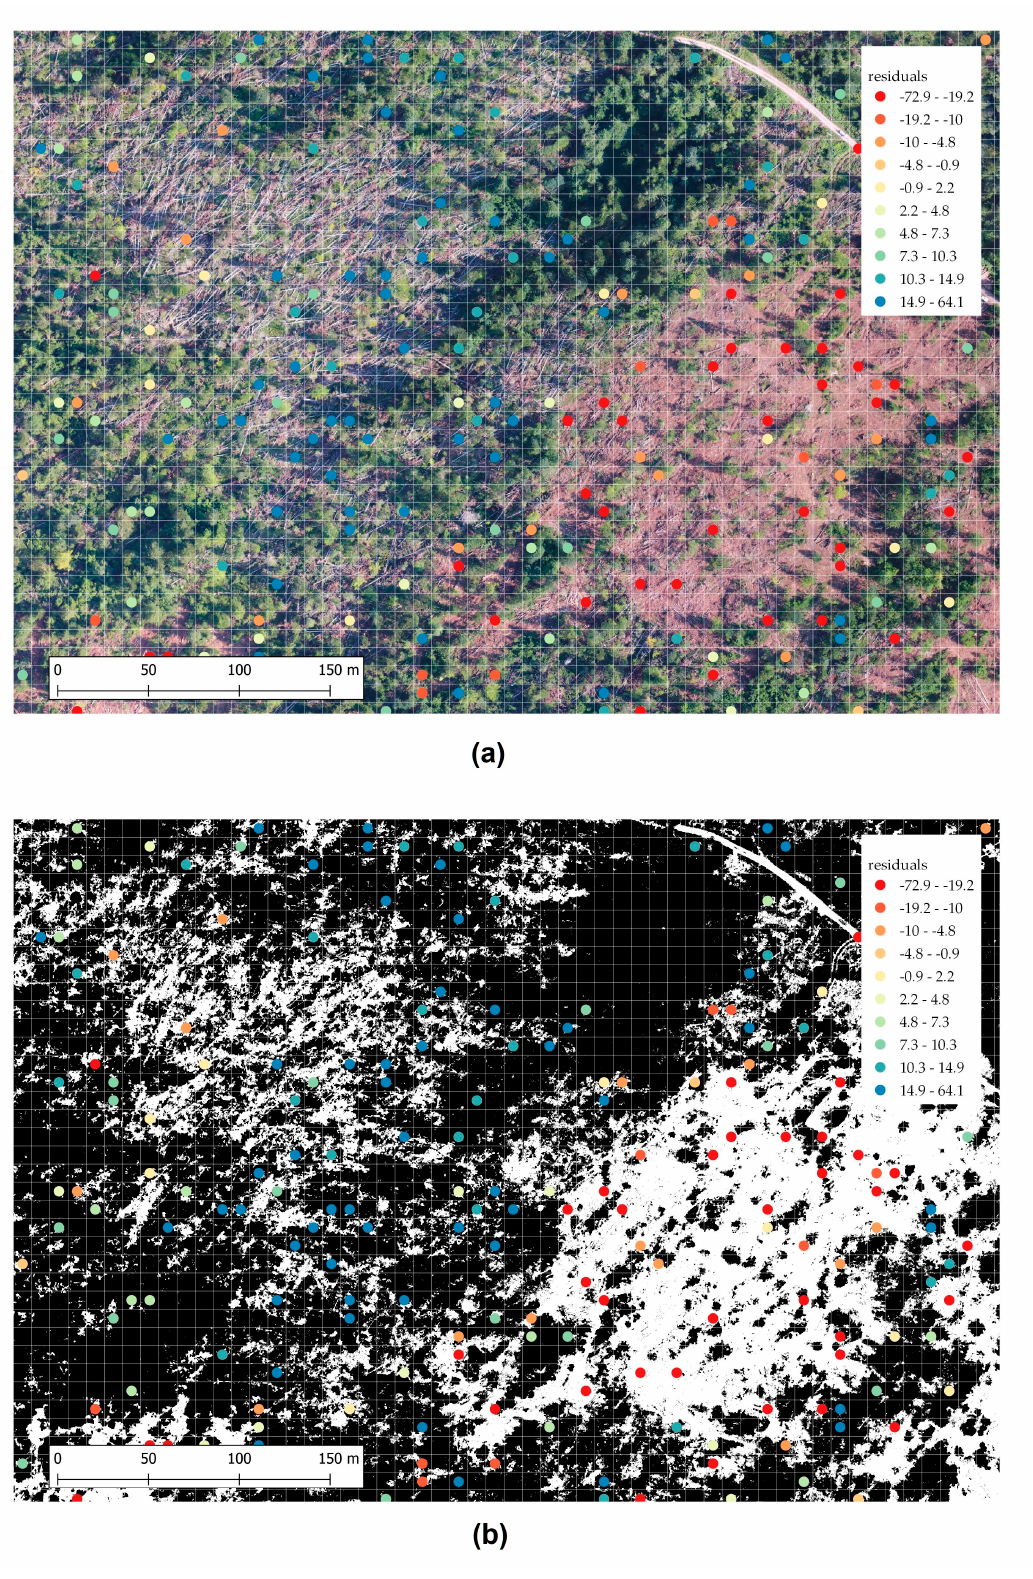
Figure 8. Representation of two cases of model discrepancies. ( a ) Contrasting areas of COP overestimation (blue points) and underestimation (red points); ( b ) the same forest segments with the UAV mask overlay with visible dissimilarity in abundance of open areas marked in